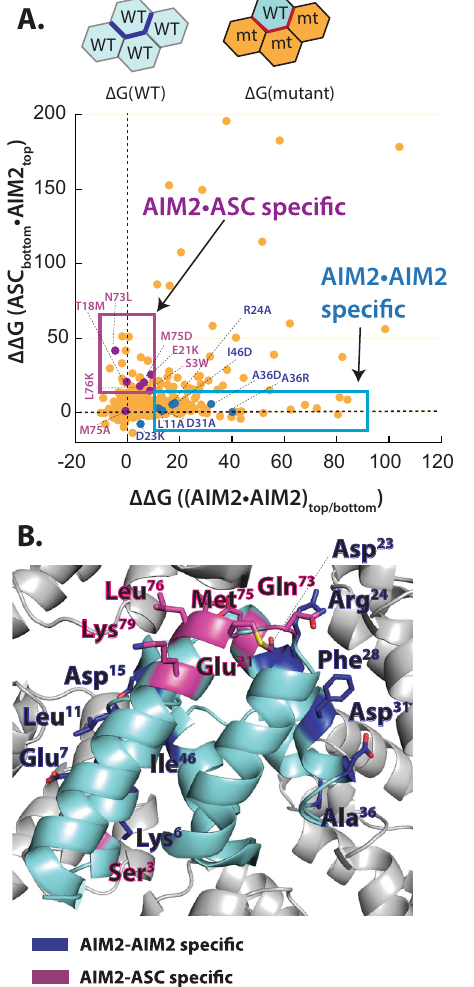
Fig. 4 in silico mutagenesis for identifying side chains that dictate the speci fi city of the AIM2-ASC in fl ammasome assembly. A Top: cartoons describing in silico mutagenesis strategy. The ligand monomer was kept WT and the interface residues of pocket monomers were mutated. The ΔΔ G value for each mutated residue was obtained by Δ G – Δ G (WT_ligand (cid:129) WT_pocket) (WT_ligand (cid:129) mt_pocket) . One pocket is shown as an example, and we applied the same strategy to all six pockets described in Fig. 2 (mt: mutant). Bottom: a plot of AIM2 PYD mutations that would interfere with AIM2 PYD (cid:129) AIM2 PYD or AIM2 PYD (cid:129) ASC PYD interaction. Selected mutations for follow-up biochemical and cellular studies are indicated. B A cartoon of the AIM2 PYD fi lament indicating the residues that Rosetta predicts to interfere with either homotypic assembly or ASC PYD recognition when